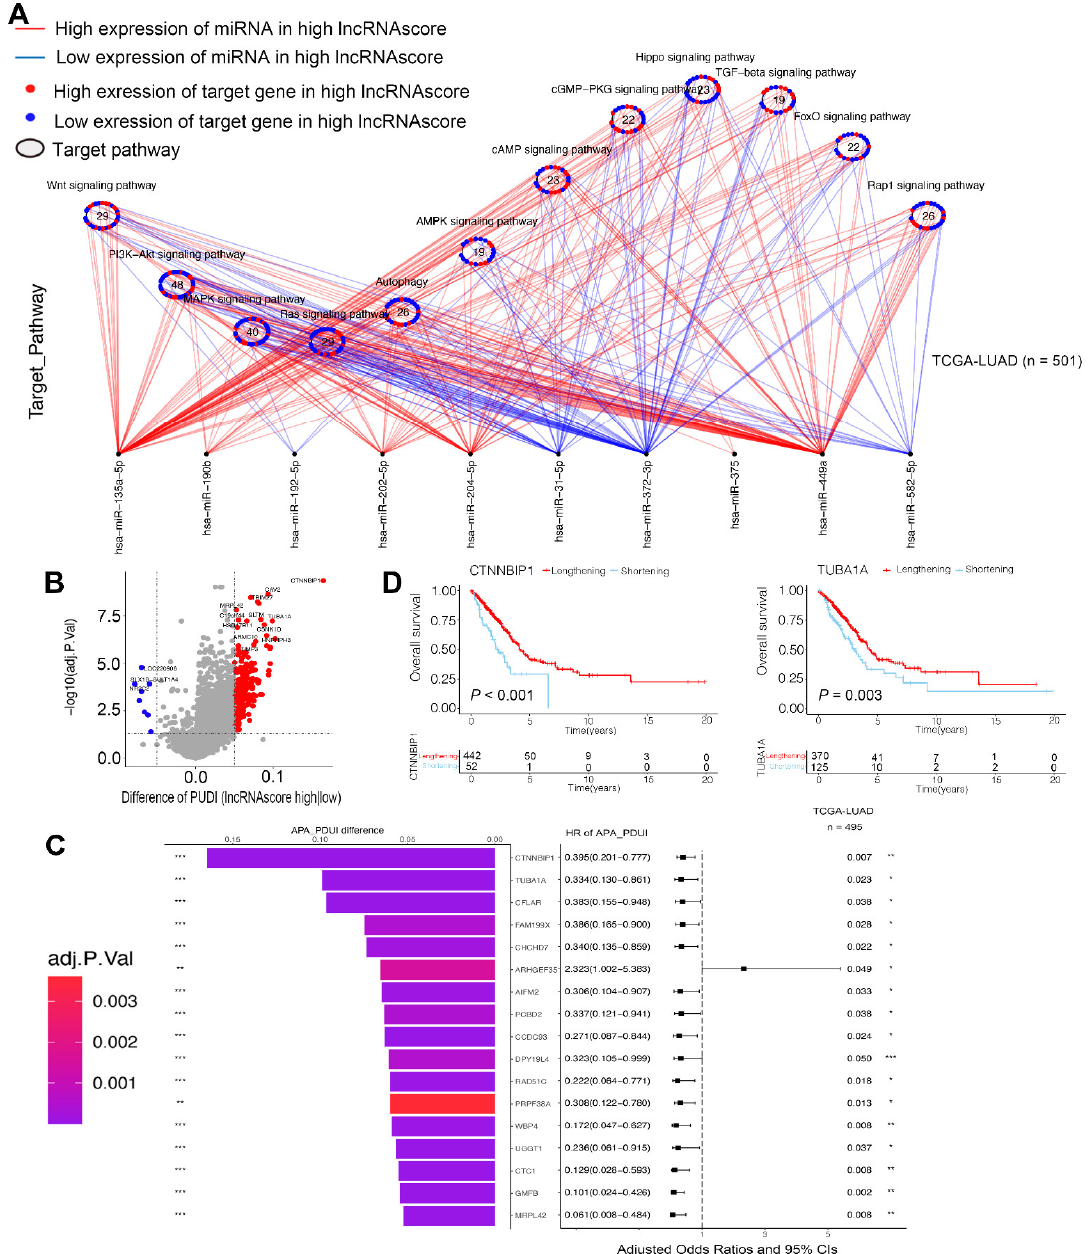
Figure 8. LncRNA score associated with the post-transcriptional characteristics. ( A ) Differences in miRNA-targeted signaling pathways in the TCGA-LUAD cohort between the high and low lncRNA score groups; ( B ) Differences in PDUI of each gene between the high and low lncRNA score groups; ( C ) The bar graphs showed the difference in the distal poly(A) site usage index (PDUI), and the forest plots showed univariate Cox regression analyses for PDUI differential genes between the high and low lncRNA score groups; ( D ) Kaplan–Meier curves indicated overall survival between PDUI lengthening (red) and PDUI shortening (blue) of CTNNBIP1 and TUBA1A. * P < 0.05, ** P < 0.01, *** P < 0.001.